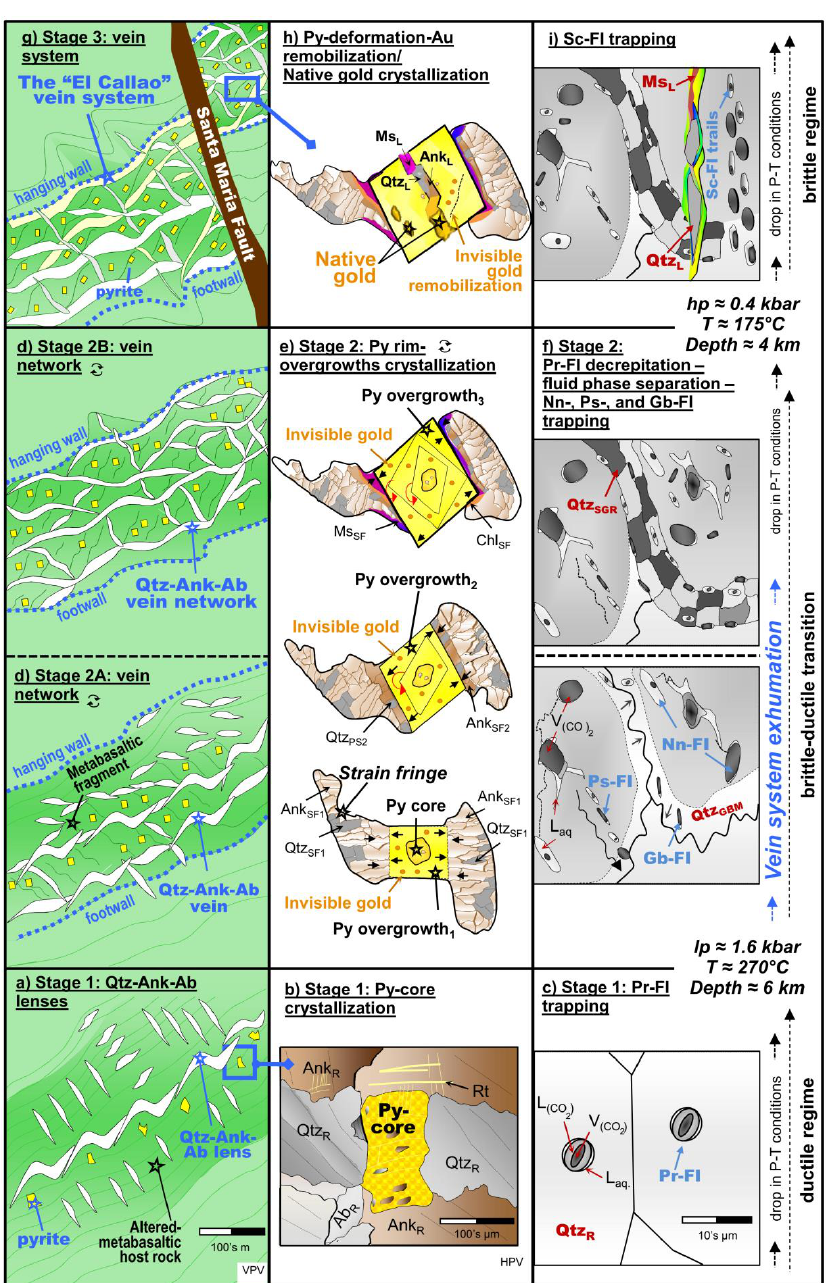
Figure 12. Schematic model for the El Callao vein system, temporally correlating (bottom to top) the sequence of structural events with the development of zoned pyrite crystals and fluid evolution. ( a – c ) Early stage of vein development, showing: quartz + ankerite + albite lenses formation ( a ), pyrite core crystallization ( b ), and primary fluid inclusions (FI) trapping ( c ), under ductile conditions. ( d – f ) Vein network formation takes place from the connection of several lenses ( d ), accompanied by multiple cycles of crystallization of pyrite rim-overgrowths (containing invisible gold nanoparticles) ( e ), (indicated by the red circular arrows), which are in turn accompanied by crystallization of gangue minerals in the empty space (indicated by the black arrows) to form strain fringes, and ( f ) primary-FI decrepitation. ( g – i ) Final stage, showing the late semi-brittle high-angle Santa Maria fault ( g ) crosscutting the entire vein system and subsequent fracturing of pyrite crystals ( h ), which are infilled by native gold